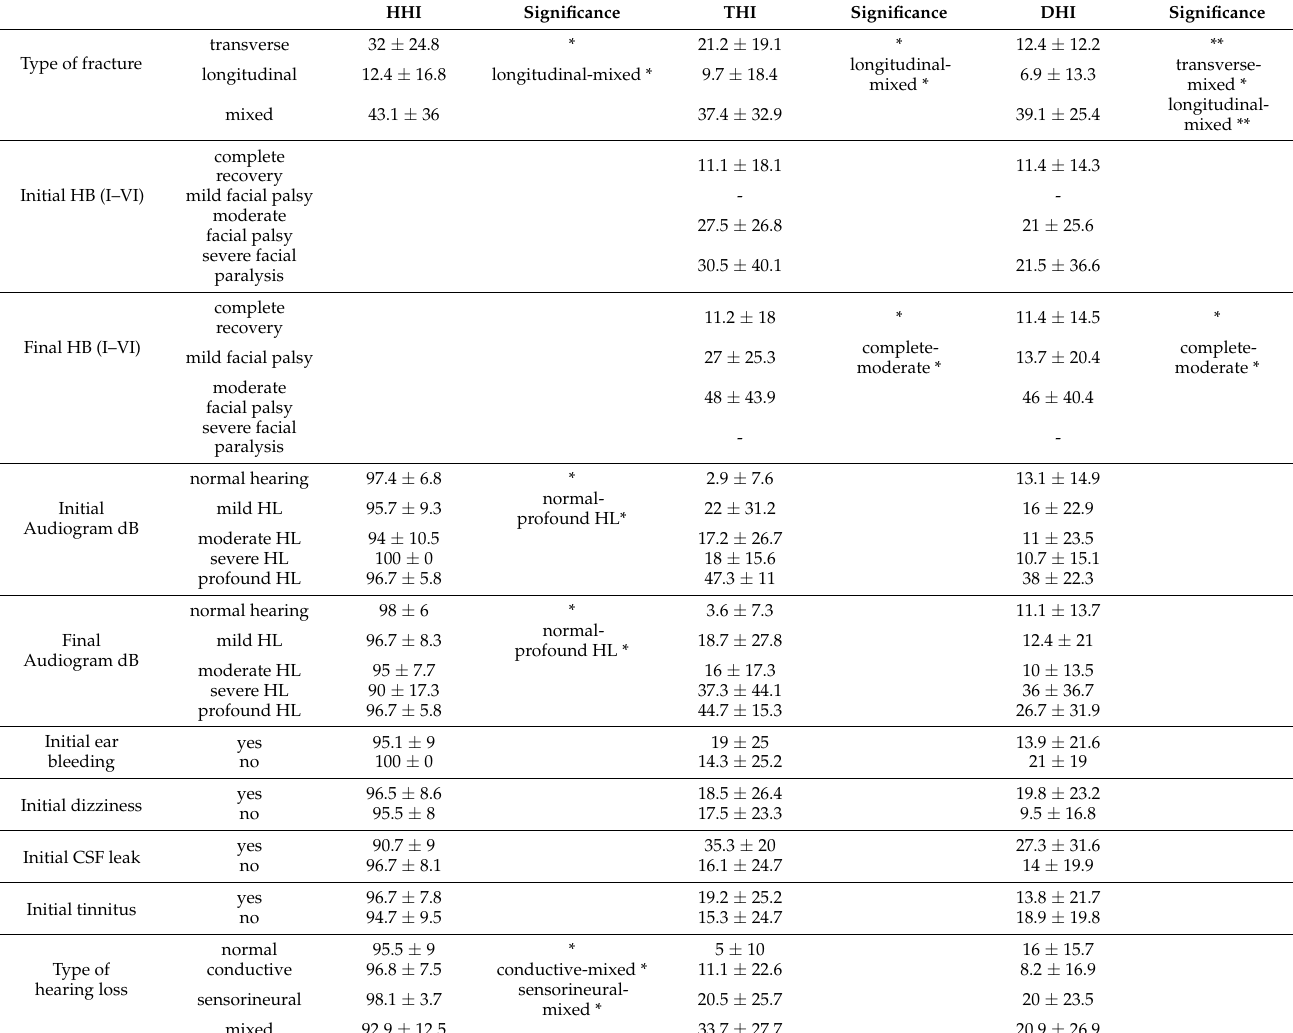
Table 4. Mean values and standard deviation of neurotological parameters for Hearing Handicap Inventory (HHI), Tinnitus Handicap Inventory (THI) and Dizziness Handicap Inventory (DHI).